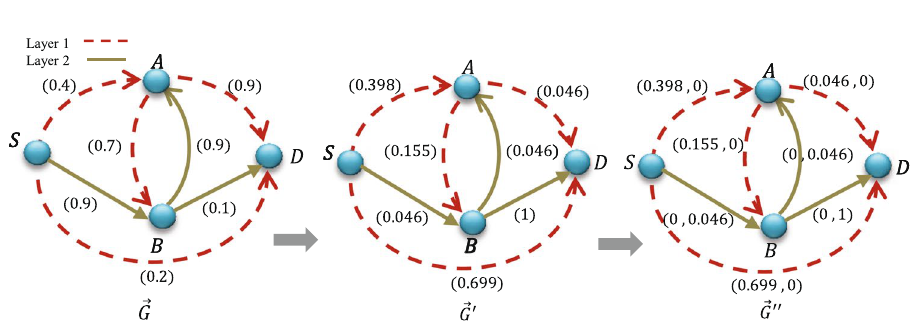
(cid:31)(cid:30) G for the two-layer weighted multiplex network. (cid:31)(cid:30) G is the graph constructed by changing the influence of each link based on